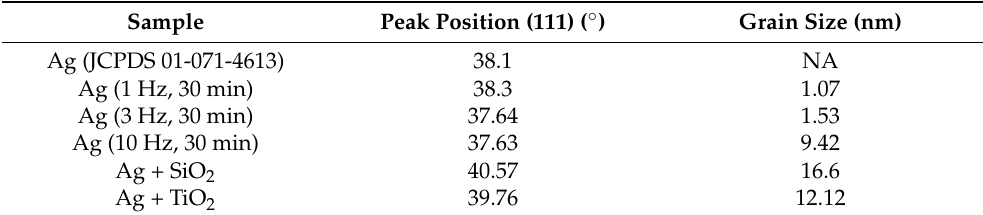
Figure 6. XRD spectra of thin films obtained during 30 min sputtering of Ag at 1 Hz, without any oxide ( b ), with TiO 2 ( c ), and with SiO 2 ( d ), respectively. The position of Ag peaks in the JCPDS card is depicted in ( a ). Table 1. Maximum peak position for Ag (111) (according to JCDPS no. 1-071-4613 card), the equivalent position of measured maxima and the grain size of the investigated samples.